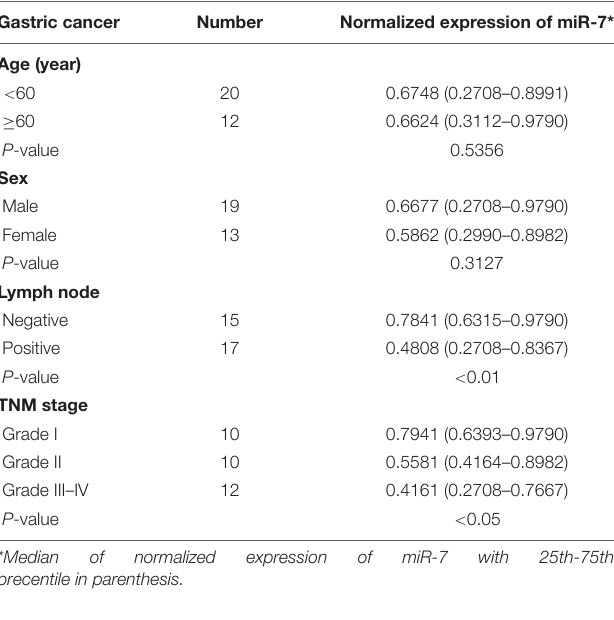
TABLE 1 | Comparison of clinicopatothologic factors and normalized expression of miR-7 in 32 pairs of GC. Gastric